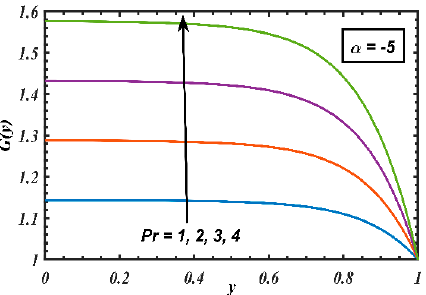
Figure 8. Variation of G(y) in converging channel for Pr = 1, 2, 3, 4 and H = 0, Re = 100, α = − 5 0 , Ec = 0.5.